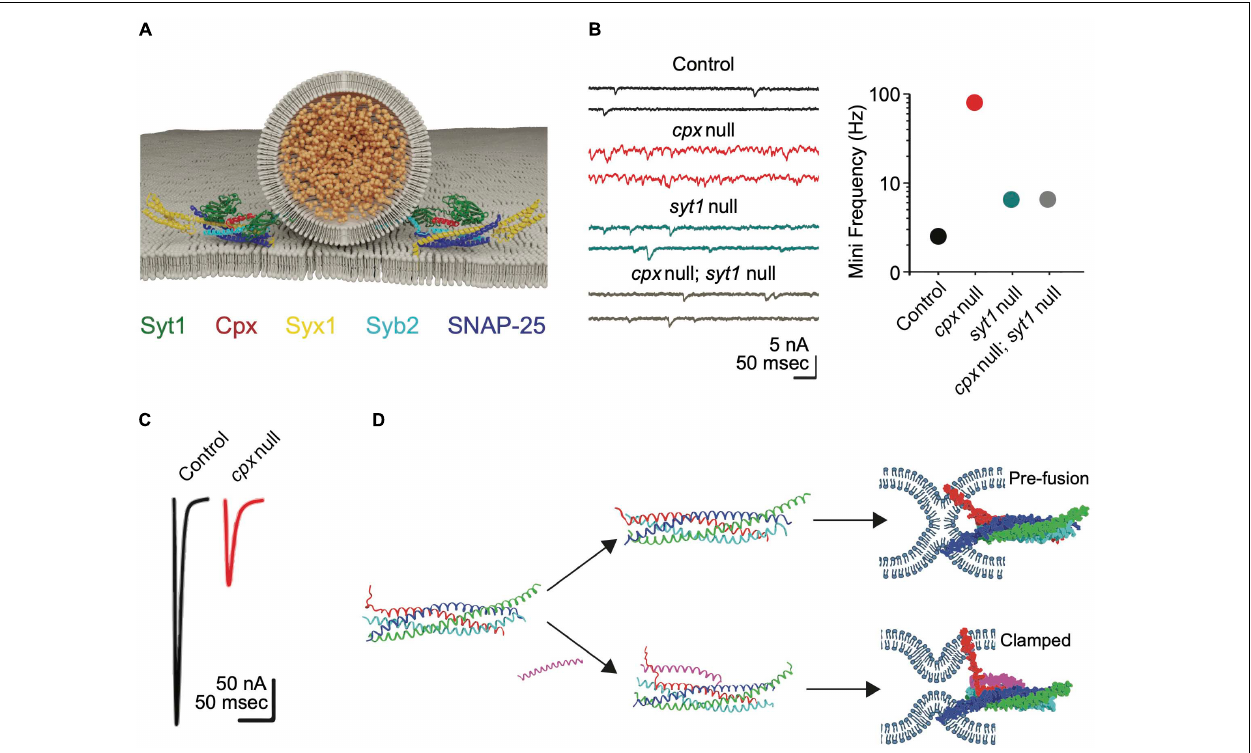
FIGURE 3 | Cpx clamps the SNARE complex in a partially assembled state. (A) Cpx and Syt1 engage the SNARE complex on a shared binding interface to form a tripartite complex. Adapted from Zhou et al. (2017). (B) Electrophysiological recordings at Drosophila larval NMJs reveal cpx null mutants have a dramatically increased rate of spontaneous release. Spontaneous release is restored to near normal levels in syt1; cpx double mutants, indicating Syt1 is required for the elevated mini rate in cpx single mutants. Quantification of spontaneous release rate (mini frequency) is shown on the right for the indicated genotypes. (C) Evoked response amplitude is reduced in cpx null mutants, indicating Cpx is also required for efficient Ca 2 + -activated release. Panels (B,C) adapted from Jorquera et al. (2012). (D) Molecular-dynamics modeling suggests Cpx may clamp SNAREs in a partially assembled state by altering the confirmation of the C-terminus of Syb2 to prevent full SNARE zippering. Adapted from Bykhovskaia et al.